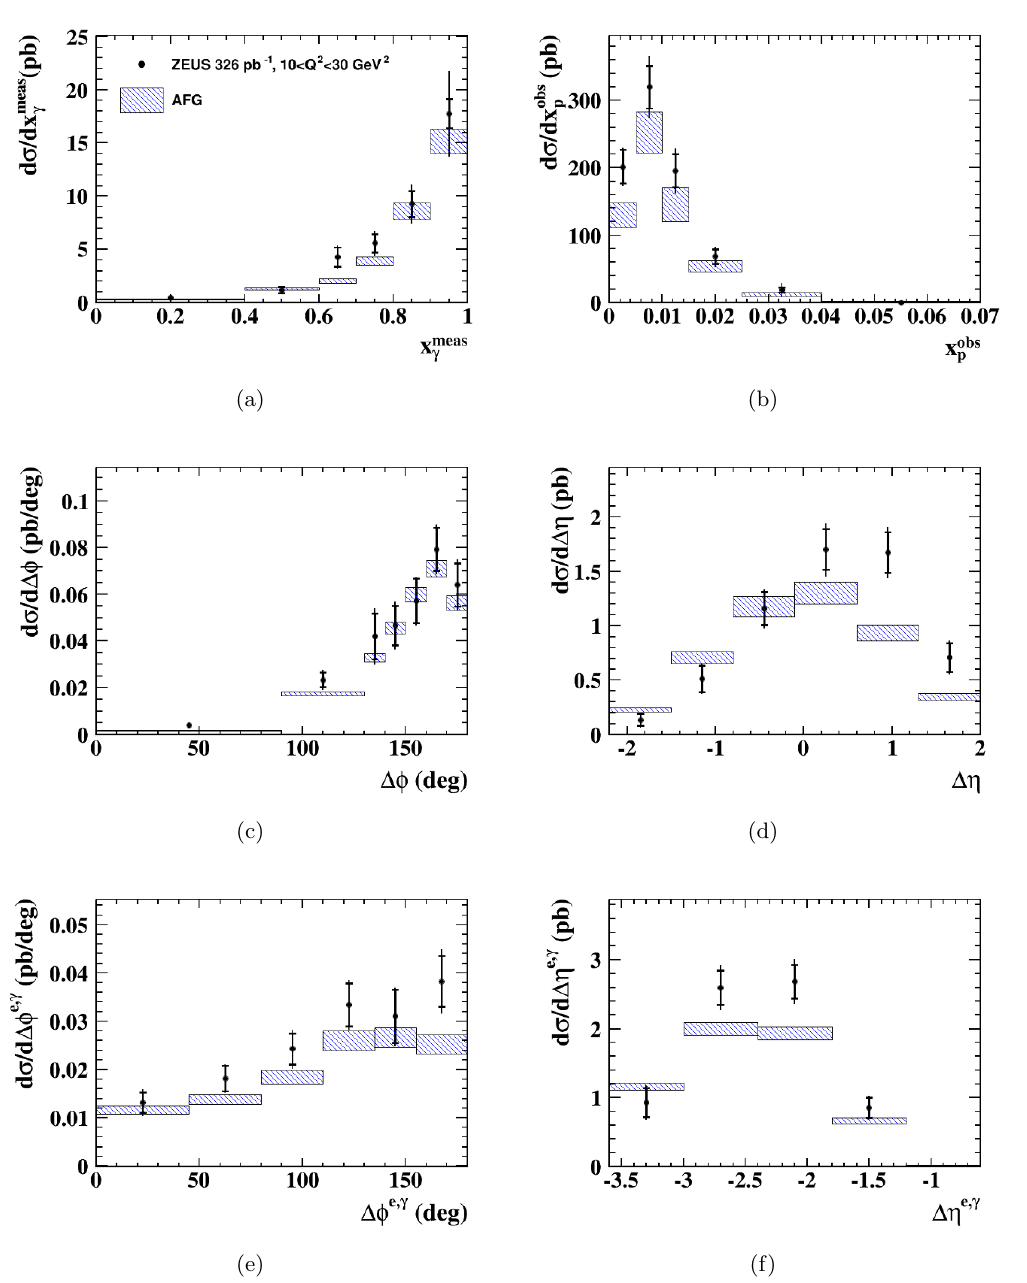
Figure 8 . Di(cid:11)erential cross sections for selected variables in the region 10 < Q 2 < 30 GeV 2 as in (cid:12)gures 4, 5. Theoretical predictions from Aurenche et al. (AFG) are shown, with associated uncertainties indicated by the bands.